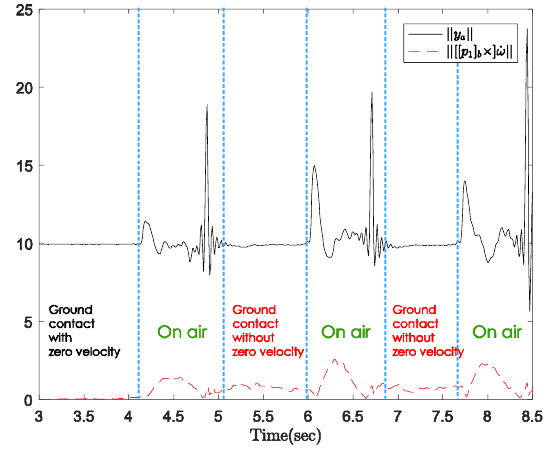
Figure 16. Acceleration norm and external